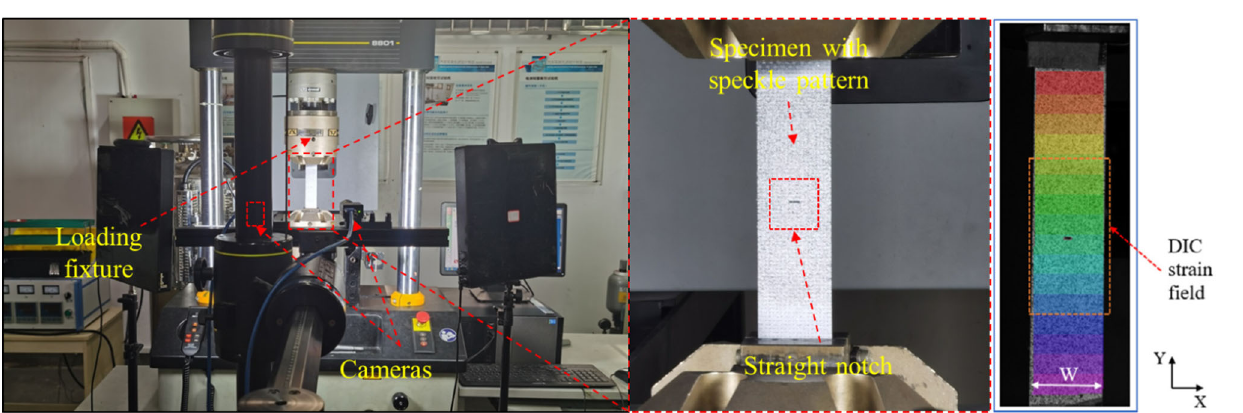
Figure 4. Tensile testing setup, using a fatigue tensile testing machine (INSTRON8801) for the tensile test. Speckle treatment was performed with white and black matte paint to facilitate observation of the experimental process using DIC technology.